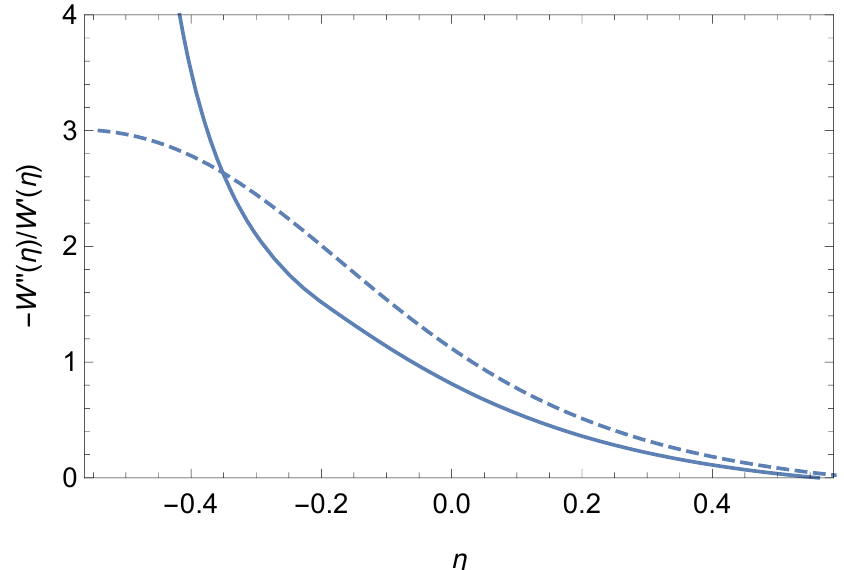
Figure 5. Induced risk aversion − W (cid:48)(cid:48) / W (cid:48) as a function of η . Parameters were set to baseline. Solid curve: model with option to rent; dashed curve: model without option to rent. Significantly, the risk aversion diverges strongly near ¯ η in the model without renting, in contrast to the model with